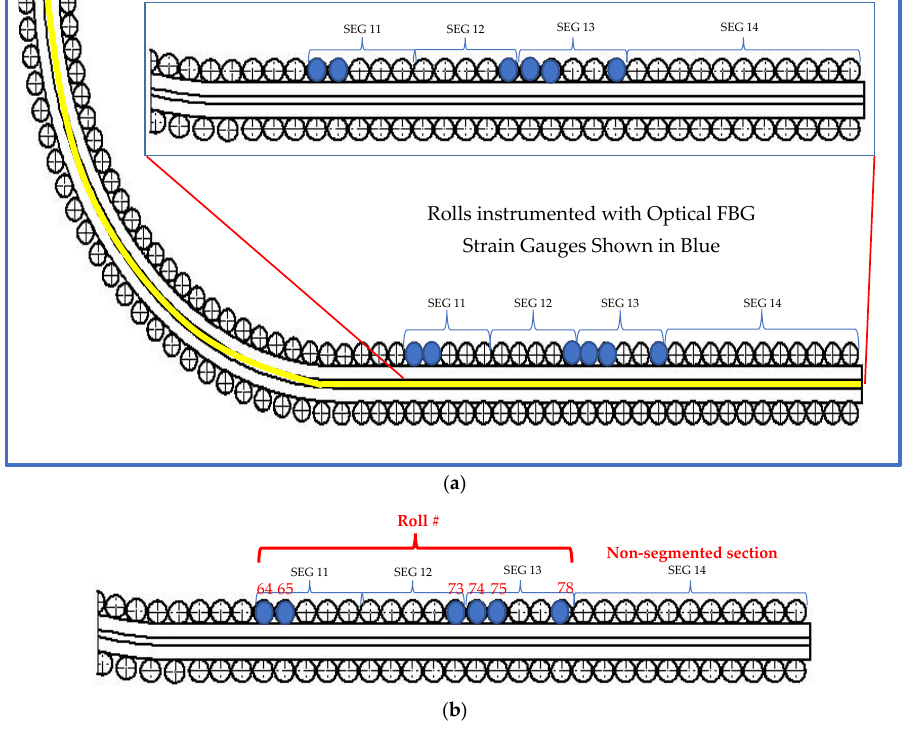
Figure 5. Location of rolls instrumented with fiber optic strain sensors, ( a ) Layout showing the caster segments and instrumented roll segments. The yellow line along the caster represents the region where liquid core is present for a specific operating condition. ( b ) Image shows roll location instrumented with optical FBG strain gauges and interrogated.